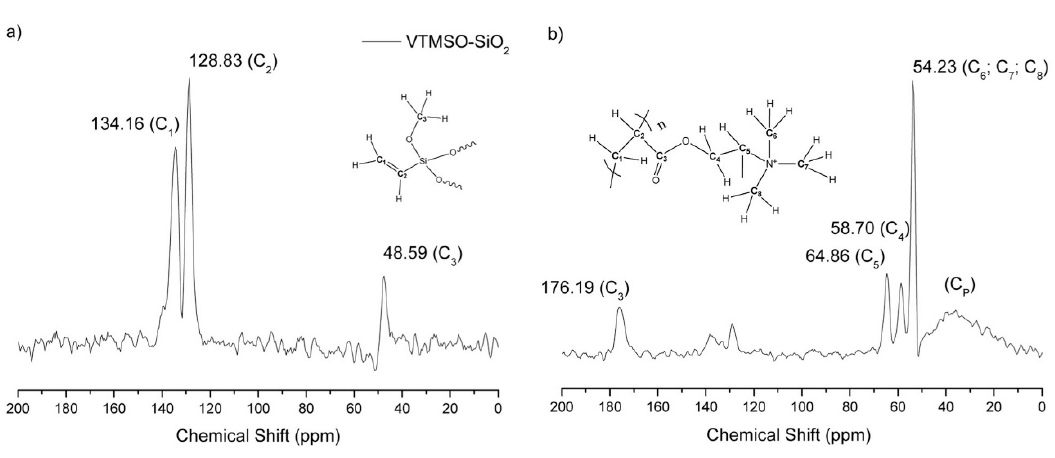
Figure 3. FT-IR spectrum of SiO 2 ( a ), VTMSO-SiO 2 ( b ), and Q/VTMSO-SiO 2 ( c ).